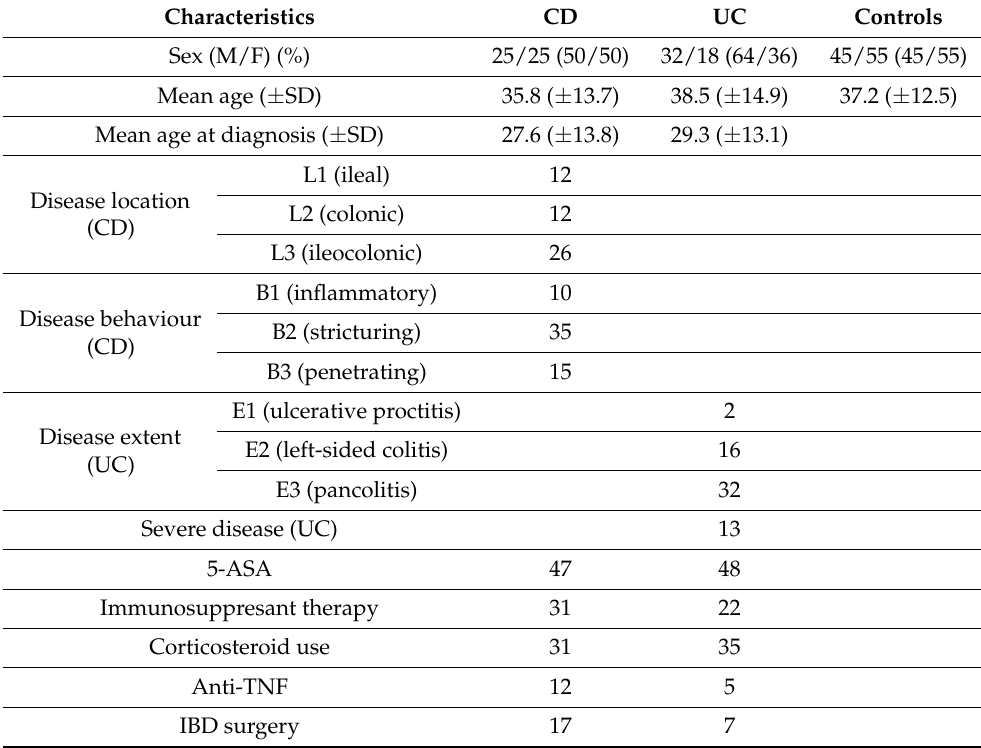
Table 2. Demographics and clinical characteristics of 100 IBD patients and 100 controls.